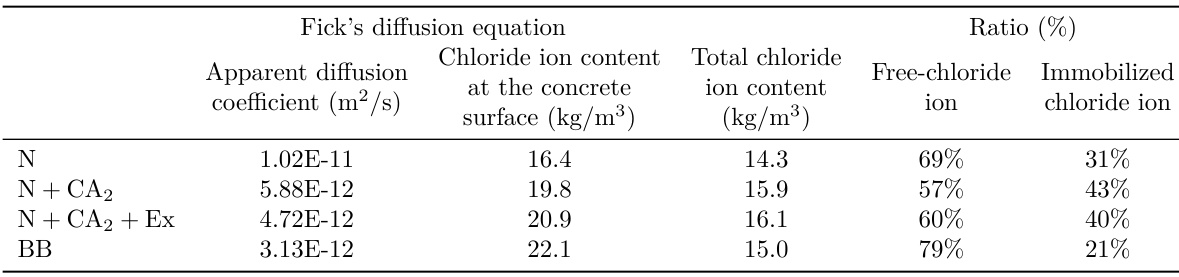
Table 3. Concrete mix proportion.